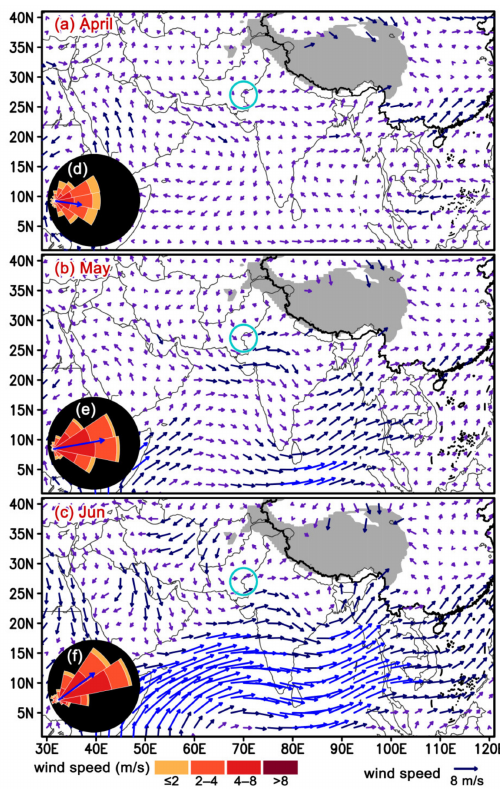
Figure 2. Mean wind (vector arrows) in ( a ) April, ( b ) May, ( c ) June, in the last 20 years (2000–2019). Subplots in ( d – f ) show the histogram distribution of downwind direction and wind speed in the border between Pakistan and India (indicated by blue circles). The grey filled area shows the Qinghai-Tibet